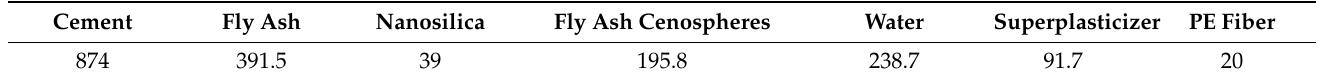
Table 4. Mix proportions of LECC mixtures (kg/m 3 ).